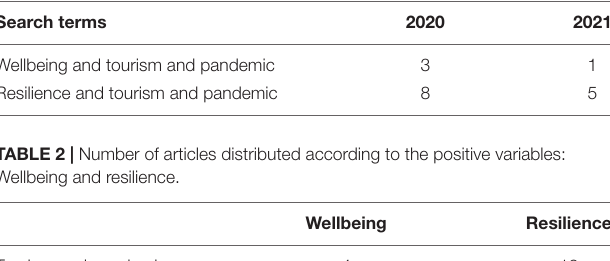
TABLE 1 | Number of articles distributed between 2020 and 2021.